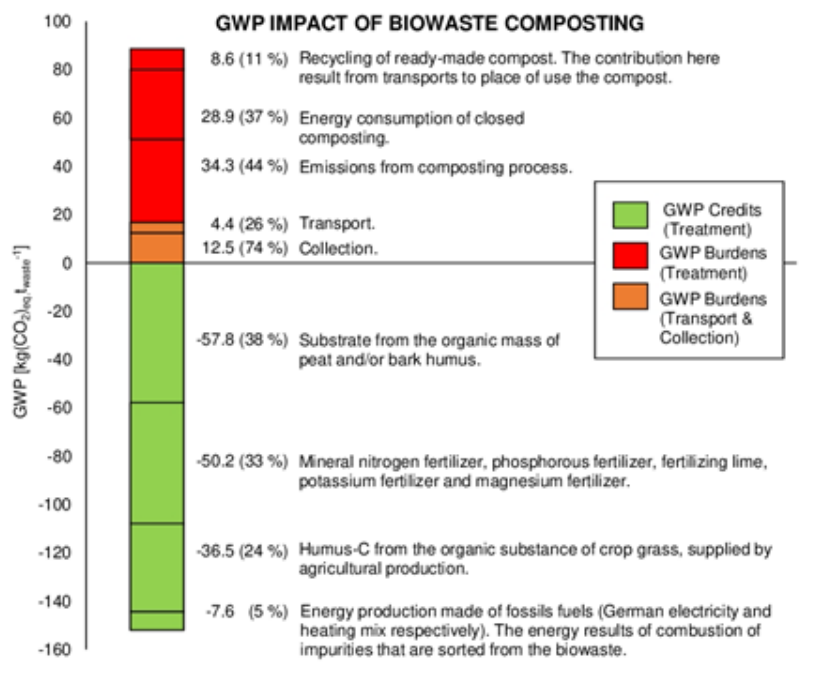
Figure 5. The overview of the environmental impact of biowaste composting expressed using GWP via SEP ‐ BIO. via